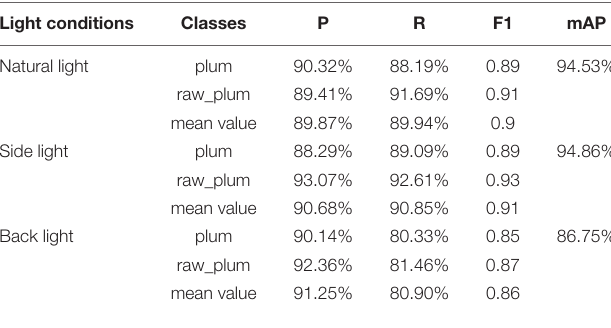
TABLE 4 | Evaluation results of plum test set under different light